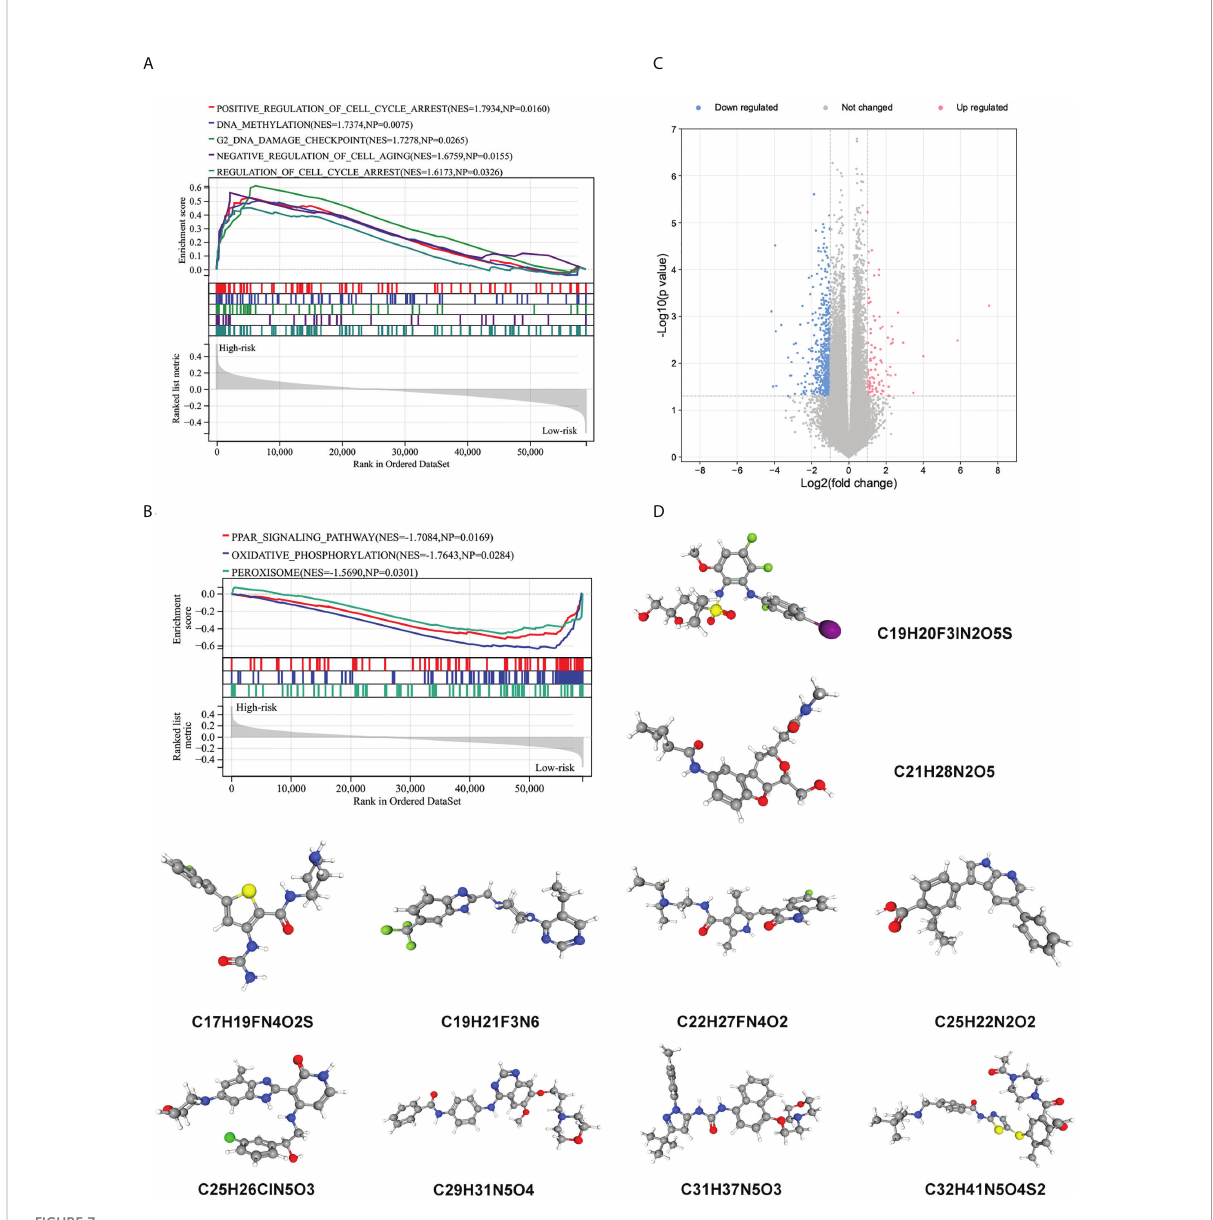
FIGURE 7 Biological function related to the immune signature and small molecule drugs exploration. (A, B) Gene set enrichment analysis of signi fi cantly enriched pathways and biological functions in the high-risk subgroup (A) and low-risk subgroup (B) . (C) Genes that are expressed differently in high- and low-risk subgroups. (D) The 3D structure of prospective drugs selected from the cMap and DeSigN